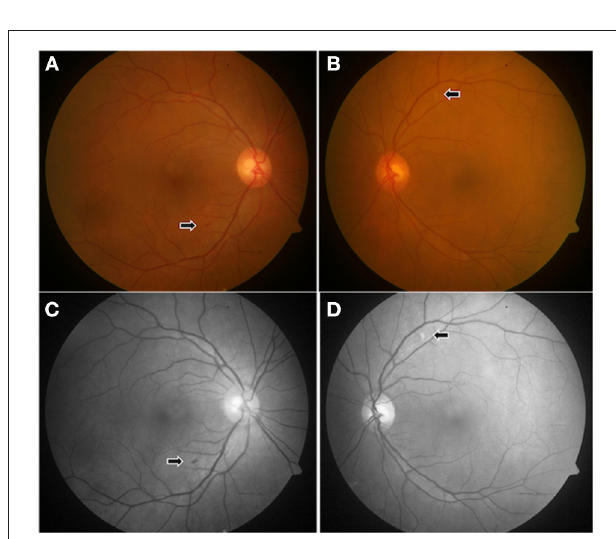
FIGURE 3 | Color (A,B) and red-free (C,D) fundus photographs of a 56-year-old female patient in convalescent phase, examined after 28 days of COVID-19 diagnosis, showing a tiny flame-shaped intraretinal hemorrhage in the right eye (arrow) near the inferotemporal arcade (A) and a CWSs in the left eye (B) , along the superotemporal arcade, which is more marked (arrow) in the red-free photograph (D) .